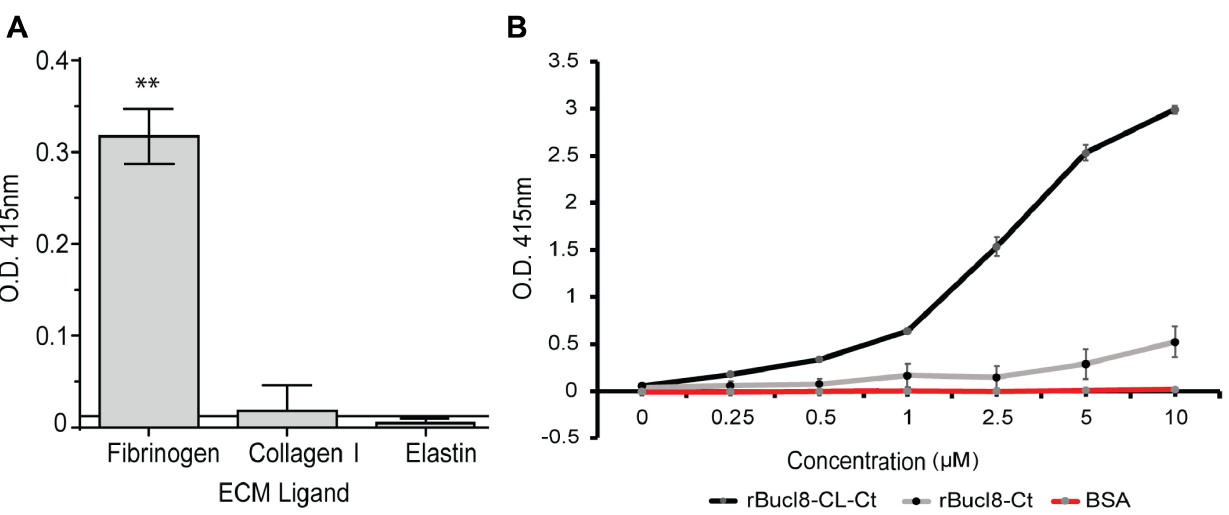
Fig 2. Binding of rBucl8-derived constructs to extracellular matrix proteins. (A) Screening assay for rBucl8-CL-Ct binding to extracellular matrix proteins. Ligand binding was tested by ELISA; representative examples of rBucl8-CL-Ct-binding-positive and binding-negative ligands are shown. rBucl8-CL-Ct binding was compared statistically with binding to BSA-coated wells plus two standard deviations; Student’s t -test, �� p � 0.01. (B) Concentration-dependent binding of rBucl8-CL-Ct and rBucl8-Ct to fibrinogen. Wells were coated with fibrinogen and either recombinant Bucl8-derived protein was added at increasing concentrations. Data represents the mean ± SEM of three independent experiments (n = 3), each performed in triplicate wells. Binding was detected with an anti-His-tag mAb.